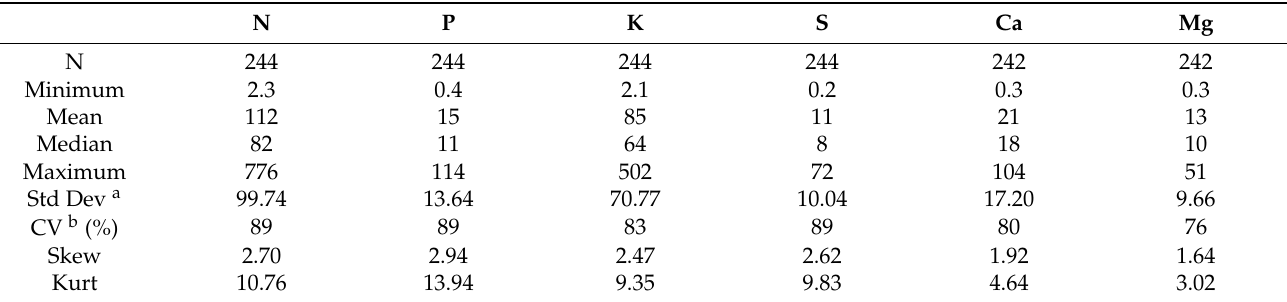
Table 4. Summary statistics for the total nutrient loads (kg herd − 1 ) deposited over a 24 h period by lactating dairy cows on the 43 grazing system dairy farms.